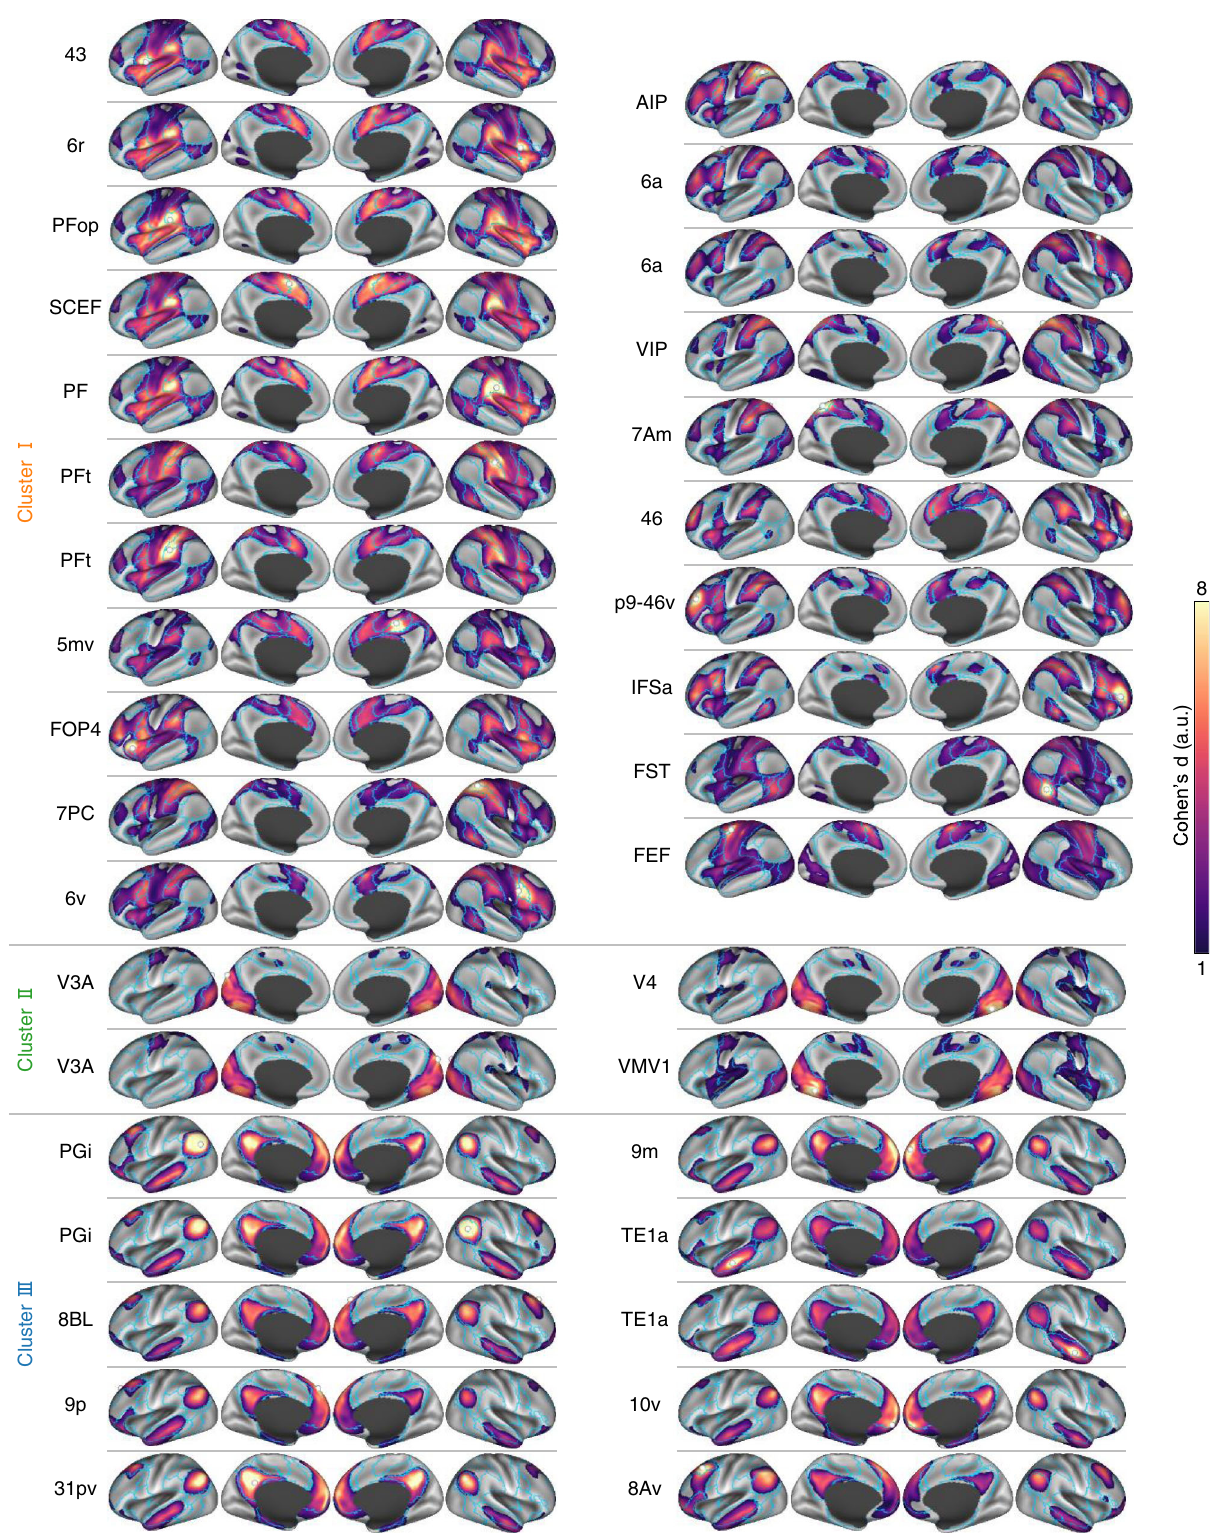
Fig. 3 Functional connectivity maps of connectome hubs. Cluster labels were derived by the hierarchical clustering solution in Fig. 4a. White spheres represent hub seeds. Blue lines delineate boundaries of the seven cortical networks shown in Fig. 1d. a.u. arbitrary task (Fig. 5f) and also achieved a reasonable peak accuracy rate worse than that using the top 150 key genes in all 1000 of 67.8% with approximately the top 150 key genes even in the repetitions (Fig. 5h). most dif fi cult classi fi cation task (Fig. 5g). By contrast, SVM Validation analyses showed that the XGBoost and SVM classi fi ers trained using 150 randomly selected genes performed classi fi ers trained using surrogate hub identi fi cation maps with